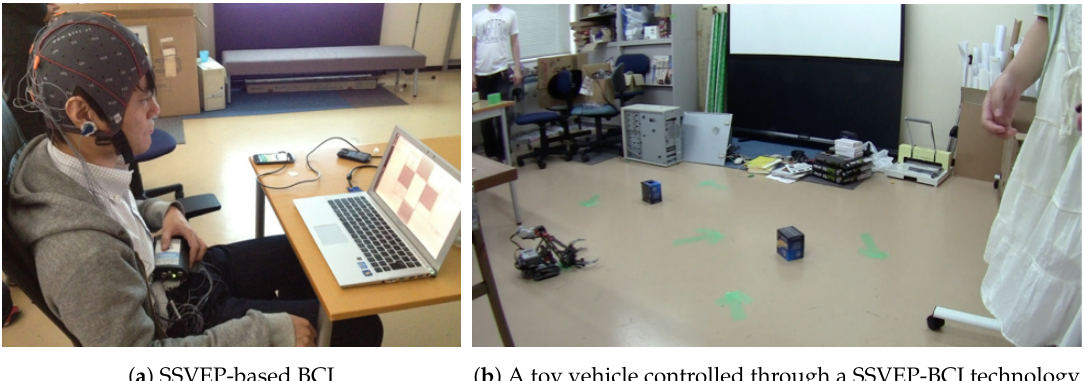
Figure 4. An experimental setup for controlling a vehicle through a steady-state visually-evoked-potentials-based BCI (from the Department of Electrical and Electronic Engineering at the Tokyo University of Agriculture and